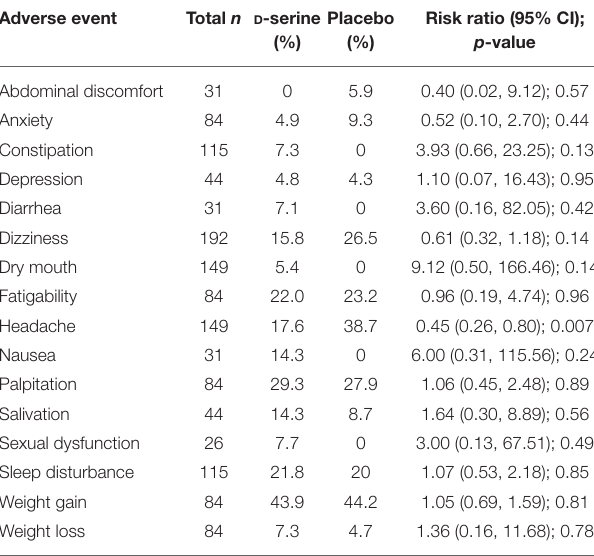
TABLE 2 | Adverse events reported in d-serine trials a